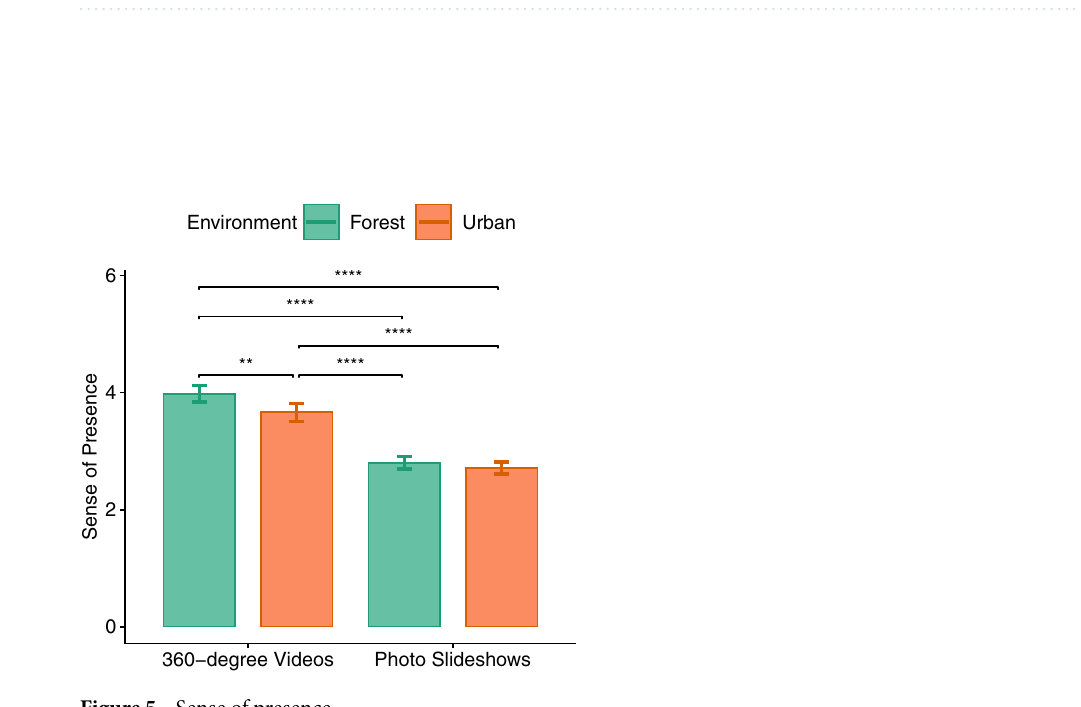
Figure 5. Sense of